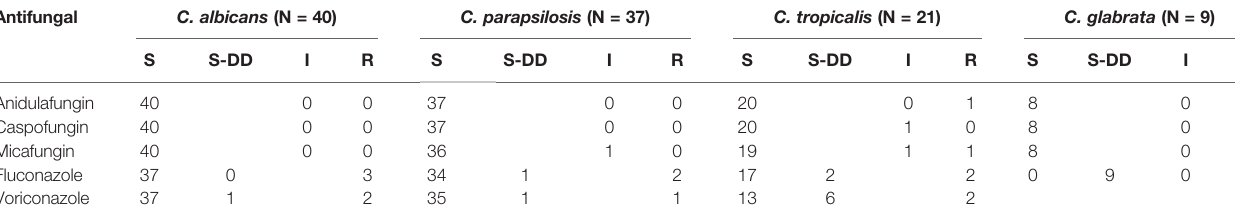
TABLE 4 | Antifungal susceptibility testing results of four main Candida species against fi ve antifungal drugs. Antifungal